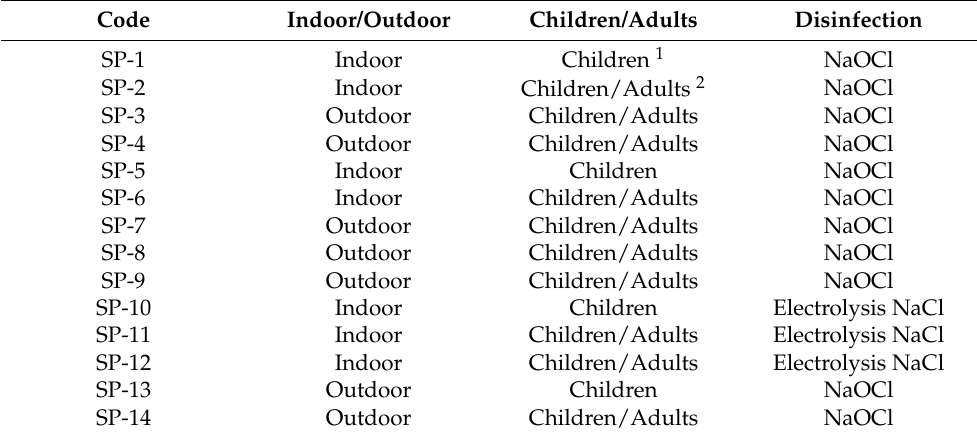
Table 2. Description of swimming